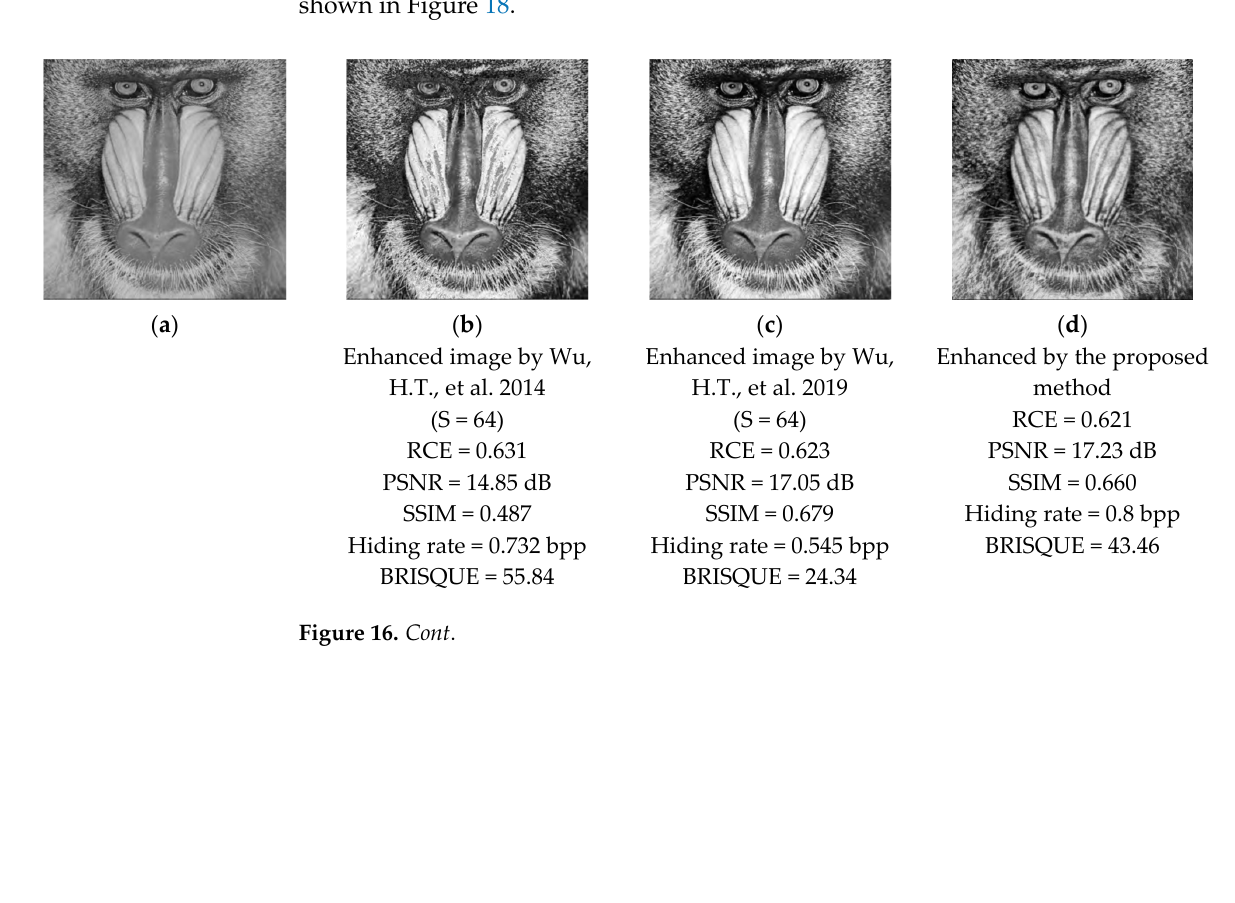
Table 8. Average metrics using the images of Figure 15 and 𝐹, 𝐶 = 1 . Hiding Rate